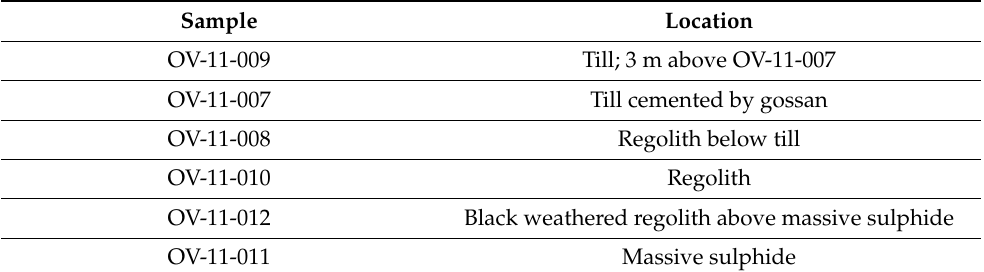
Figure 10. Ovoid open-pit mine in 2011 with locations of Mini-Ovoid and split spoon drill holes, those examined in this study are highlighted. Table 2. Stratigraphy of OV-11 samples, Mini-Ovoid, Voisey’s